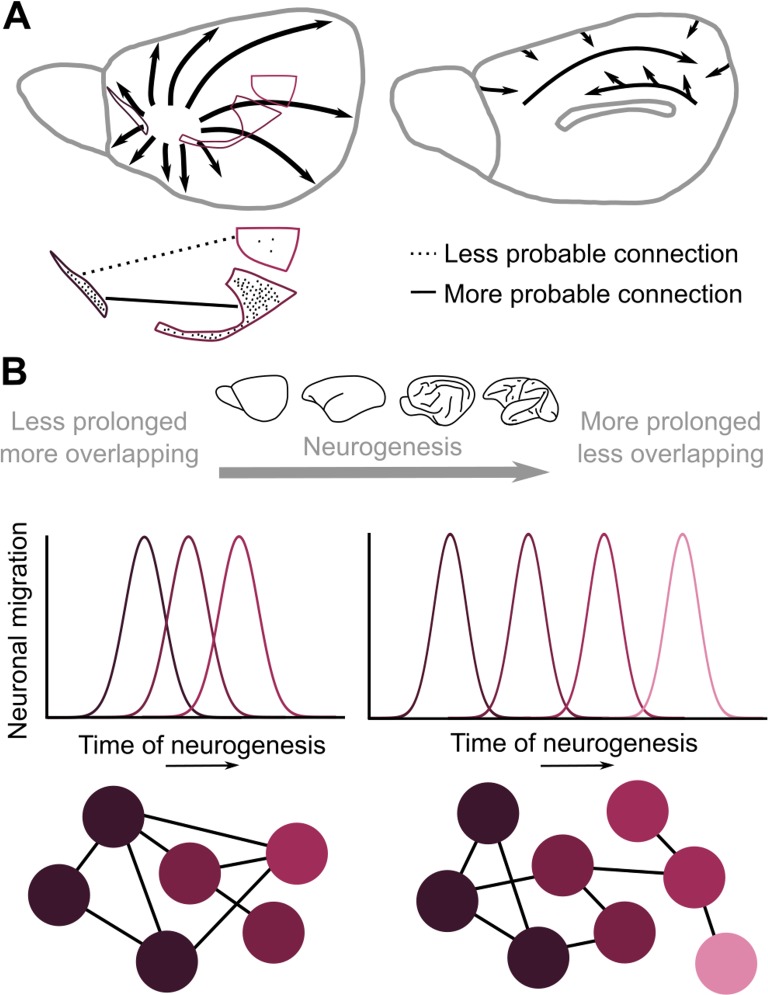
Putative neurodevelopmental mechanisms underlying the observed preferential connectivity between cytoarchitectonically similar cortical areas.(A) The cytoarchitecture of areas in the adult cerebral cortex might reflect their distinct time courses in neurogenesis. Heterochronous and spatially ordered neurogenetic gradients indicate distinct time windows in neurogenesis in the mouse, with arrows denoting the direction of propagation of neuron release and accumulation [53]. Hence, similar cytoarchitecture might entail a similar time course of neurogenesis, thus biasing the cortical connections to form primarily between areas with similar overlapping time windows, since they host more neurons functioning as probable “connection partners.” (B) The duration of neurogenesis is shorter in mice compared to macaque monkeys [54]. Overall, a shorter neurogenetic period and less distinct time windows of neurogenesis may result in the observed species-specific relation of the existence of connections and the cytoarchitecture of the cerebral cortex.